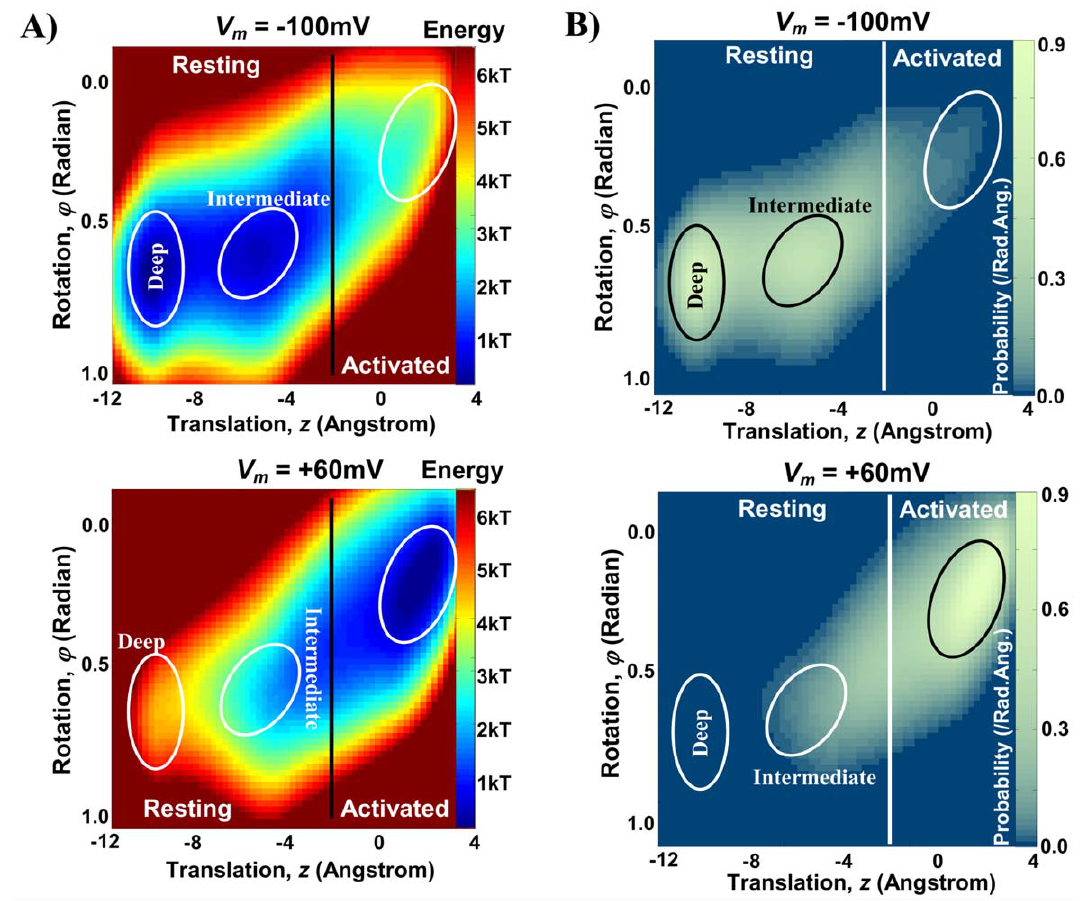
Figure 4. Energy landscapes and their associated steady state distributions (in configuration space) for two different membrane potentials. A ) Energy landscapes at two different membrane potentials V m = 2 100 mV (top) and + 60 mV (bottom). Increasing membrane potential shifts minimum energy conformations of the S4–S3 complex toward more outward positions (right side of the energy landscape). Ellipses highlight the energy minima. Vertical black line is the border between resting and activated states. B ) Steady state distribution of voltage sensors in the configuration space at a particular membrane potential; V m = 2 100 mV (top) and + 60 mV (bottom). Channels mainly reside in minimum energy conformations (highlighted by the ellipses). Note that the brightness scale is logarithmic. White vertical line marks the border between resting and activated states. In response to a sudden change in membrane potential, voltage sensors distribution varies gradually toward the steady state distribution associated with the new membrane potential (Movies S1 and